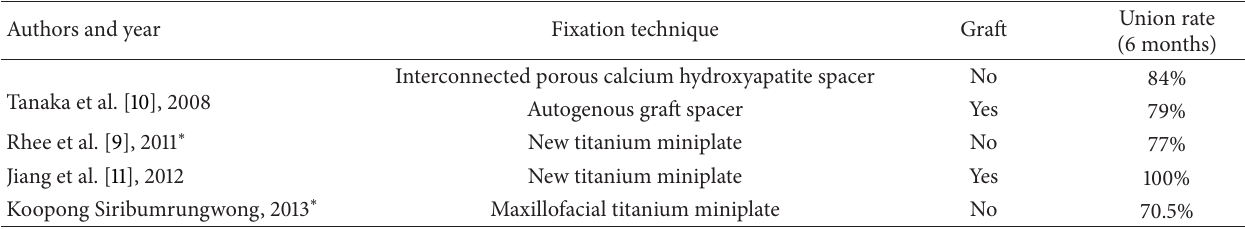
Table 1: Comparison of the union rates on the hinge side of different types of fixation.